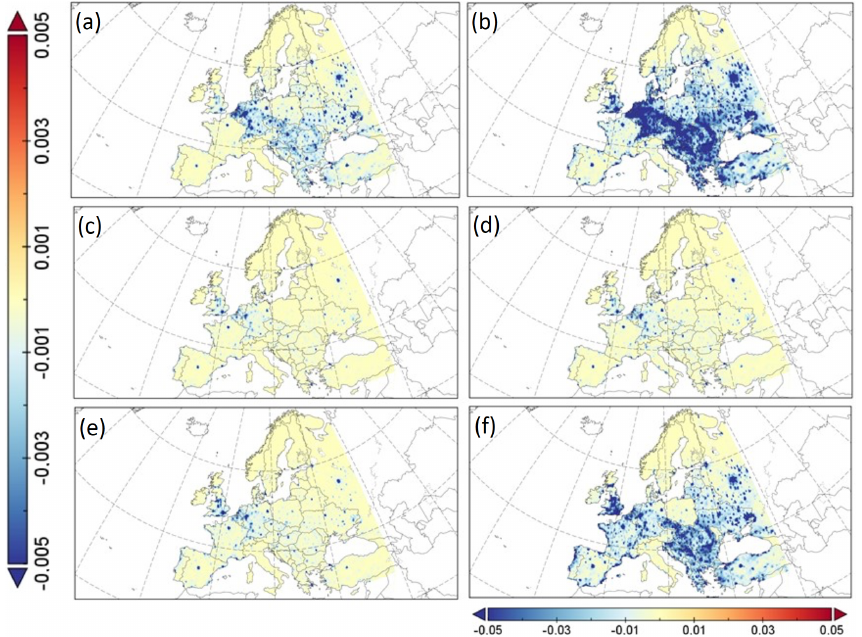
Figure 13. Differences in future premature mortality for the future scenario FUT-P2050 and the mitigation scenario (REN80-P2050) (REN80-P2050 minus FUT-P2050), both of which consider the population projections for 2050. Endpoints considered are (a) CEV, (b) IHD, (c) COPD, (d) LC, (e) LRI and (f) all endpoints. All values are in premature deaths (PD) per km 2